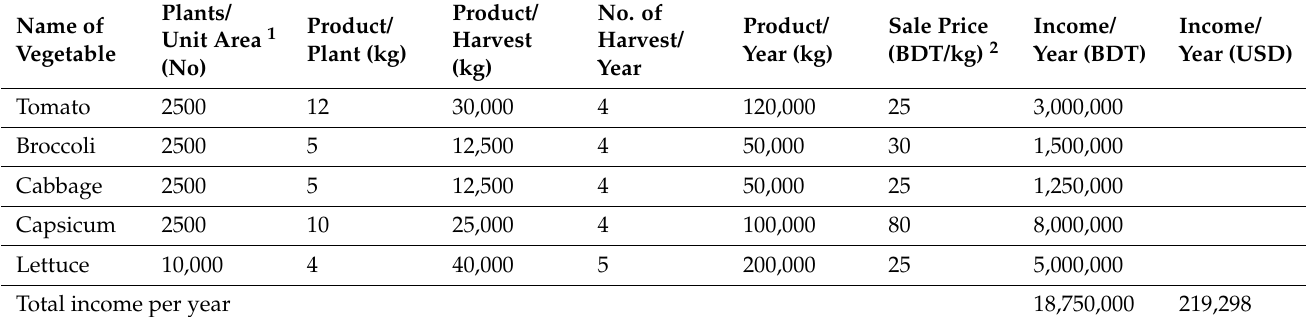
Table 3. Total production and gross income from the five selected hydroponic vegetables.